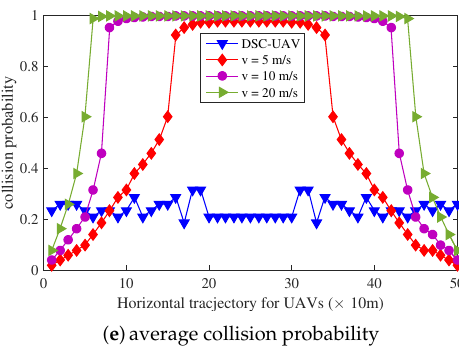
Figure 8. Verification of the proposed dynamic speed control